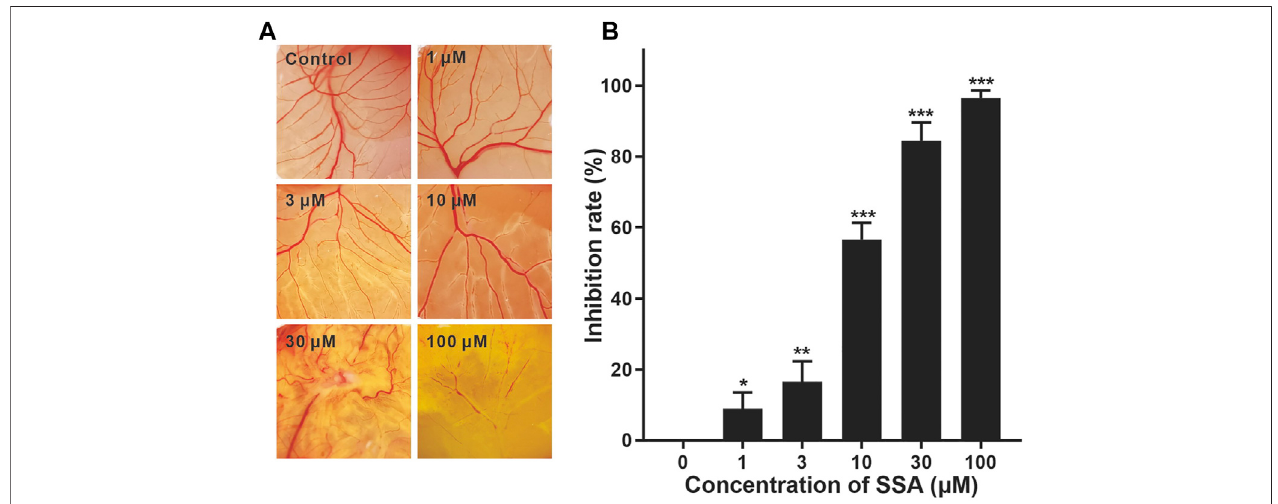
FIGURE 3 | Effect of SSA on angiogenesis in the CAM. CAMs were treated for 48 h with a 6.5-mm diameter Whatman fi lter disk previously immersed in various concentrations of SSA (1 – 100 μ M). CAM angiogenesis was photographed using a digital camera (A) and quanti fi ed using Image-Pro Plus 8.0 software (B) . Data were expressed as mean ± s .d. n (cid:1) 3. * p < 0.05, ** p < 0.01, and *** p < 0.001 as compared with the control group. SSA inhibited vascularization in the Matrigel plugs in mice.